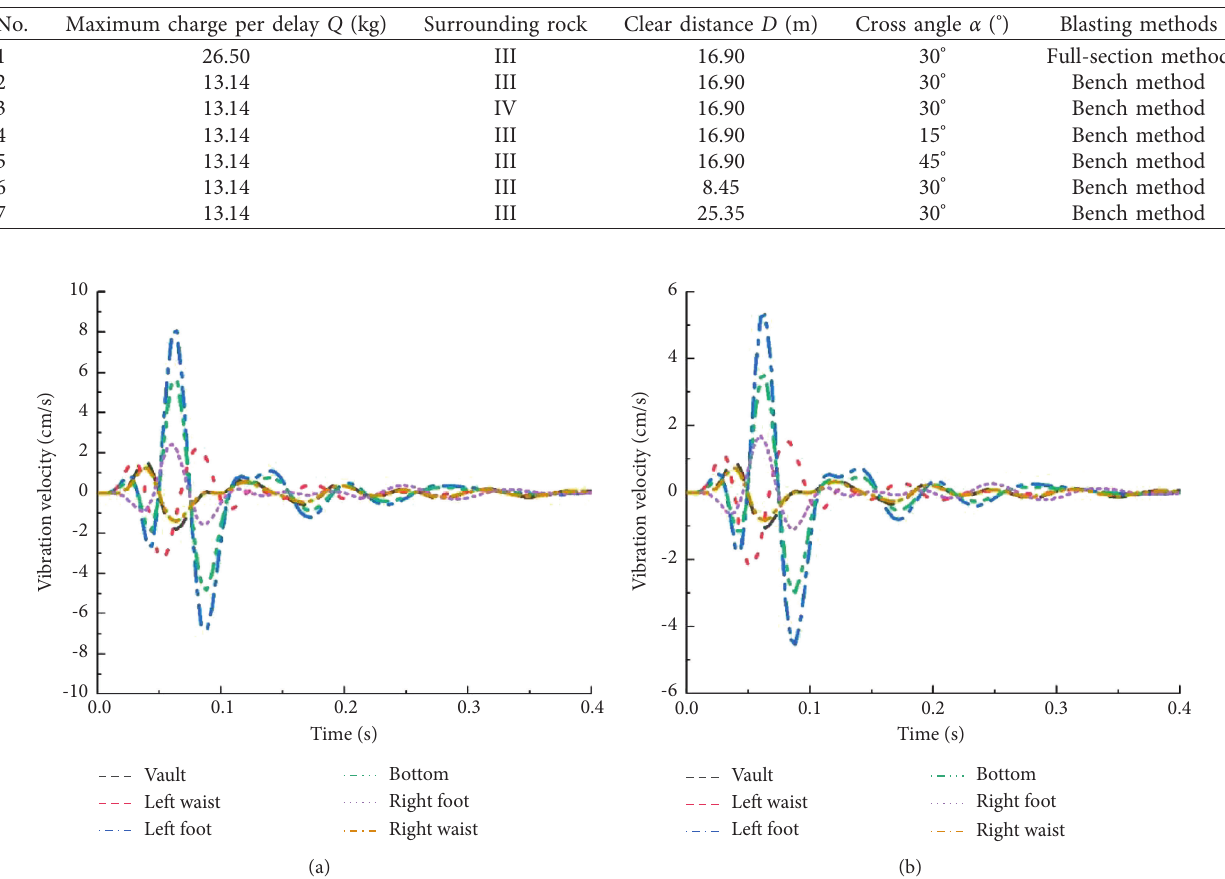
Figure 2: The vibration velocity-time history of different parts of the existing tunnel: (a) condition 1 and (b) condition